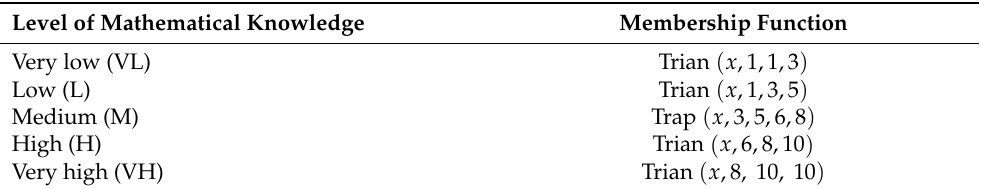
Table 2. The fuzzification of teacher-given grades.